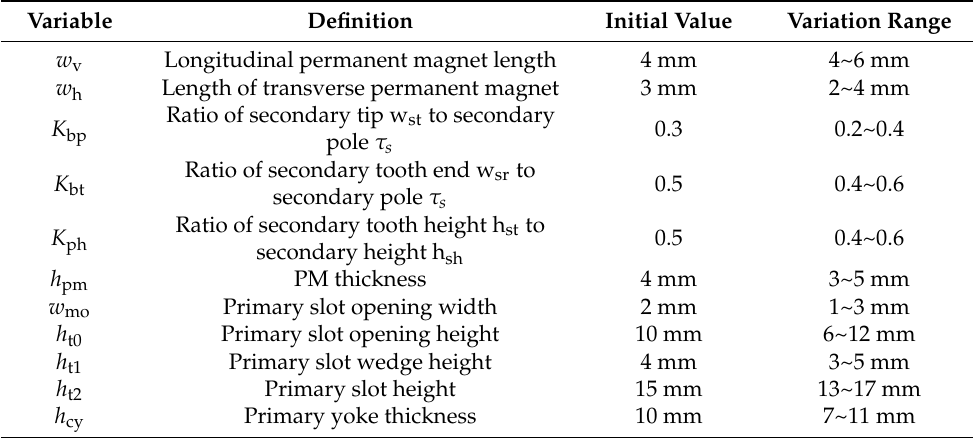
Figure 10. Multi-objective optimization flow chart. Table 2. Optimization variables of STMLPMVG.